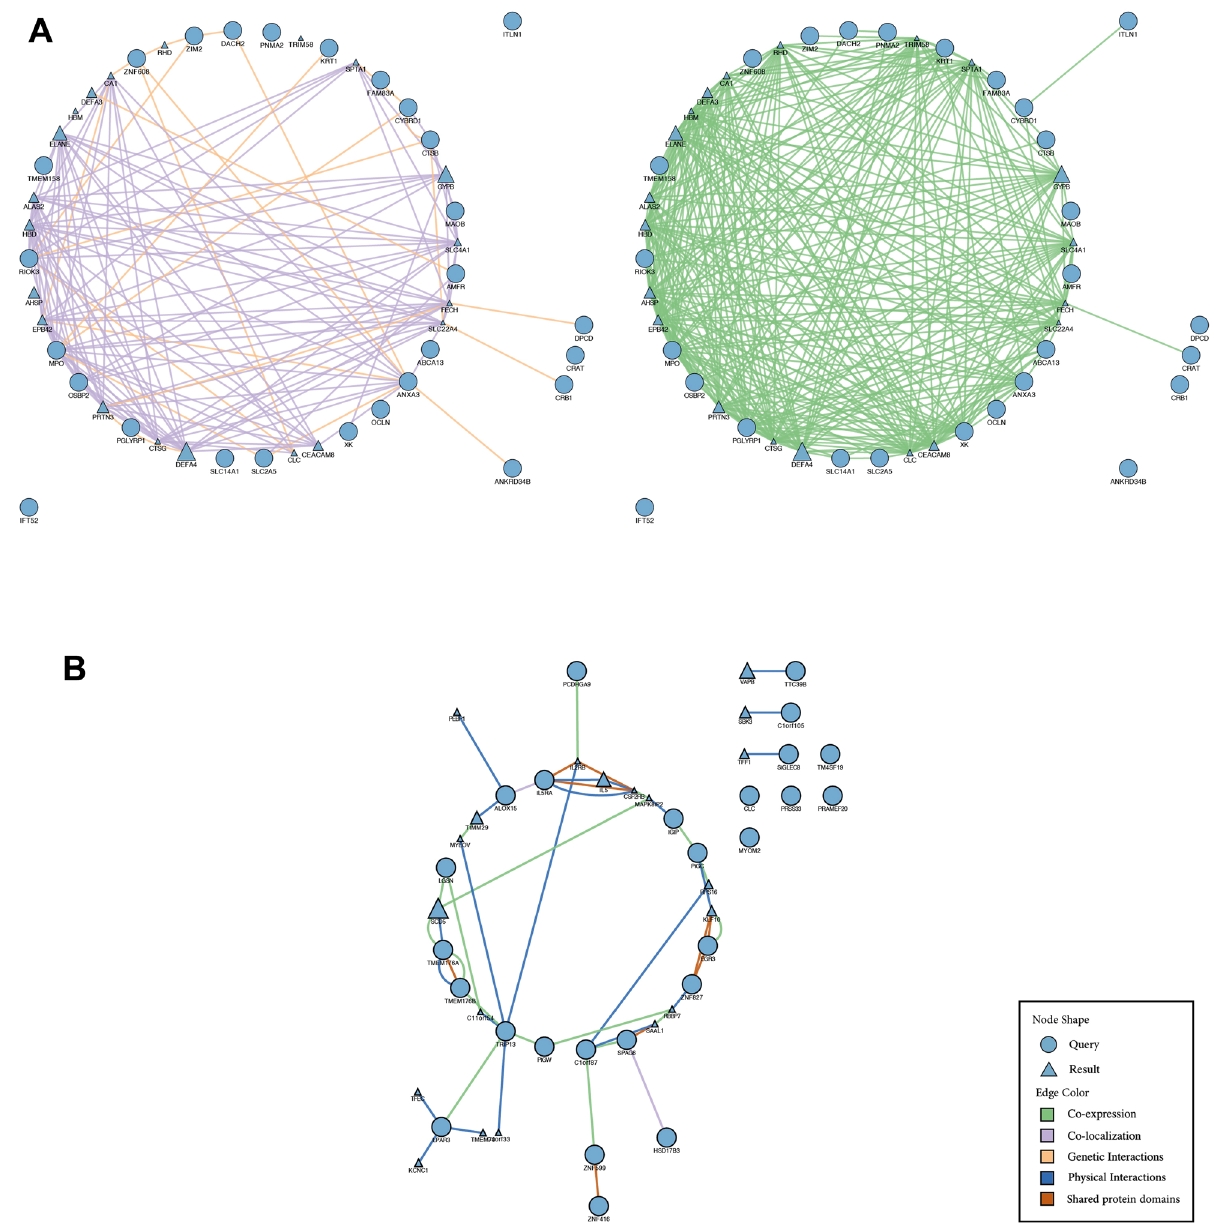
Figure 3. Candidate genes in BM SCLC patients—gene networks from GeneMANIA. ( A ) Up-regulated genes network. Physical interactions are shown in blue lines, Co-expression genes are shown in green lines, Co-localization is shown in purple lines and shared protein domains are shown in the orange lines. The higher scores are shown as a larger circle. Intermediate genes involved were also demonstrated. ( B ) Down- regulated genes network. Co-expression genes are shown in green lines, Co-localization is shown in purple lines, and genetic interactions are shown in orange lines. The higher scores are shown in black as a larger circle. Intermediate genes involved were also